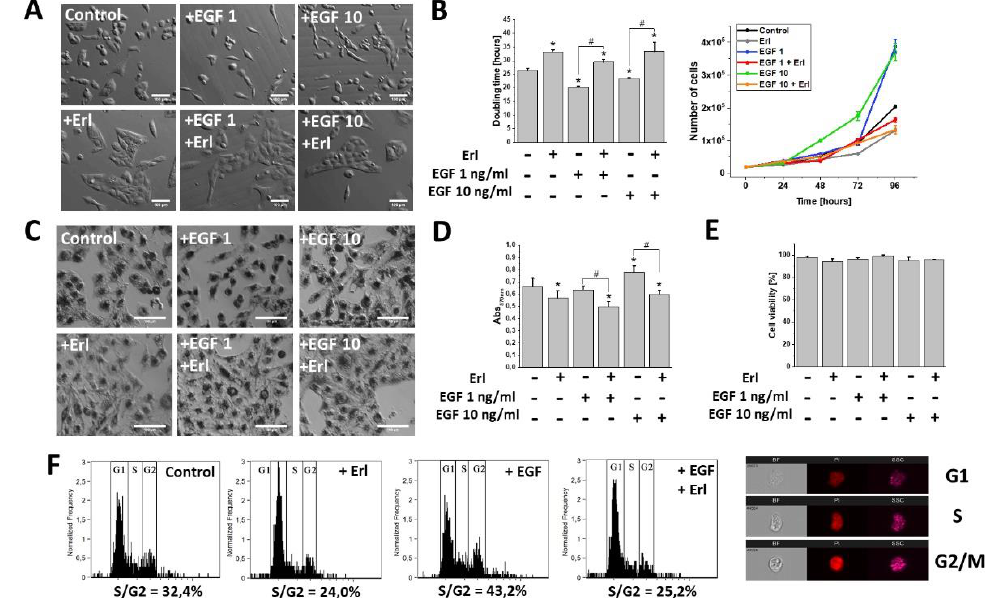
Figure 1. Effect of EGF (Epidermal Growth Factor) on GBM (Glioblastoma multiforme) cells’ morphology and proliferation activity. ( A ) EGF promoted development of a spindle-like cellular phenotype after only 24 h of incubation. Note the attenuation of this effect upon EGFR (Epidermal Growth Factor Receptor) inhibition with erlotinib (Erl). ( B ) Effect of EGF on proliferation kinetics (doubling time) modulation within GBM cells. ( C-D ) Metabolic (reducing power; MTT assay) activity of GBM cells incubated with EGF and/or Erl for 48 h. Note a pronounced MTT reduction by GBM cells during EGF incubation. The 570 nm values shown in the column plot were normalized to cell number. ( E ) EGF and Erl (72 h) showed negligible pro-apoptotic effects on GBM cells. ( F ) Pro-mitotic activity of EGF within GBM cells resulted in an increased percentage of S/G2-phase cells. Images on the right show representative objects collected during cytometric cell cycle analysis in three different channels (BF: bright-field; PI: propidium iodide; SSC: side scatter). Bars represent SD, n = 3. Statistical significance was calculated with non-parametric Mann–Whitney test, * p < 0.05 vs. control; # p < 0.05 vs. reference condition. Scale bars = 100 µm.